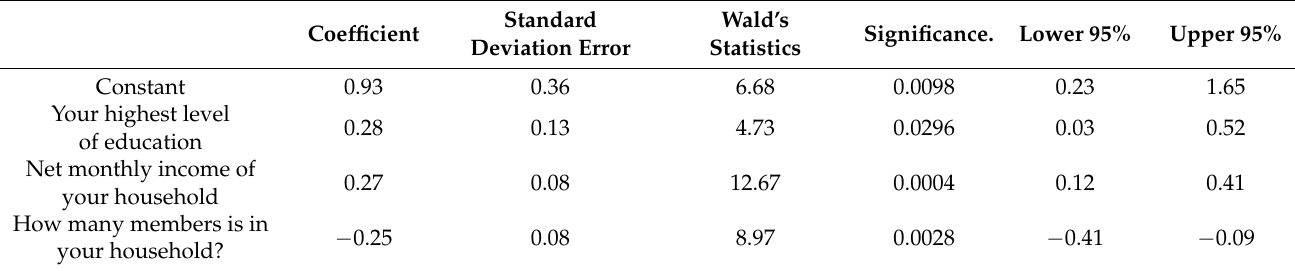
Table 2. Regression model parameters.